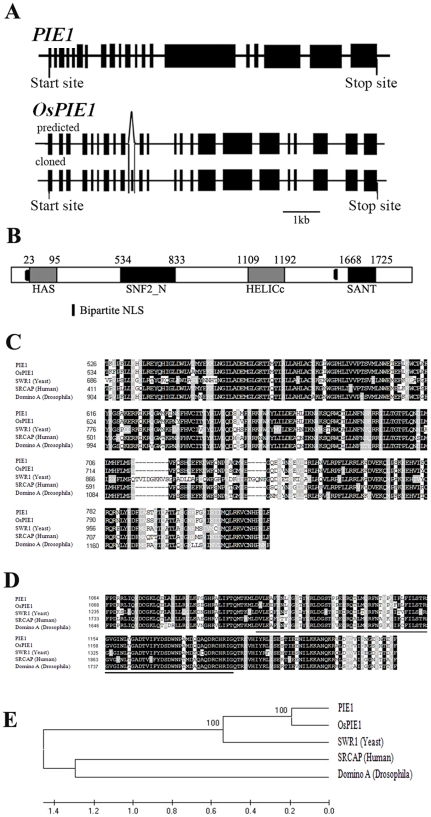
Genomic structure of OsPIE1 gene and sequence alignment of OsPIE1 homologs.(A) Genomic structure of OsPIE1 and Arabidopsis PIE1 genes. The translation start and stop sites are indicated. Exons are presented as filled black rectangles, and introns or intergenic sequences are presented as solid lines. For OsPIE1, the upper diagram (“predicted”) depicts the predicted structure of the OsPIE1 gene in the RiceGE database with 21 introns and 22 exons. The lower diagram (“cloned”) represents the structure of the OsPIE1 gene cloned and verified in this study, with an extra exon within the predicted 9th intron, corresponding to nucleotides 2368 to 2437 of the genomic fragment. (B) Domains of OsPIE1. Domains are predicted by the SMART program (http://smart.embl-heidelberg.de) and the amino acid numbers of these domains are indicated. The two putative bipartite nuclear localization signals (NLS) at the N-terminal and C-terminal regions of OsPIE1 are KRQKTLEAPKEPRRPKT and KKRDLIVDTDEE KTSKK, respectively. (C) Sequence alignment of the SNF_N domains of OsPIE1, Arabidopsis PIE1, Drosophila DOMINO A, human SRCAP, and yeast SWR1. Numbers indicate the amino acid positions. (D) Sequence alignment of HELICc domain. Amino acids corresponding to the domain are underlined. Numbers indicate the amino acid positions. (E) A phylogenetic tree of OsPIE1 orthologs from several organisms. The names of organisms are indicated in parenthesis, and bootstrap values are provided for the indication of reliability for each node.